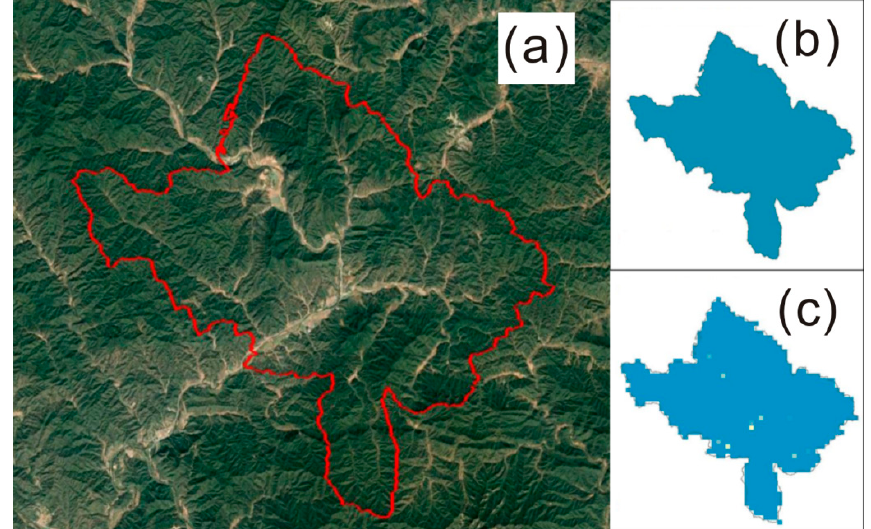
Figure 14. Comparison of the Google Earth image ( a ), census population data ( b ) and remotely-sensed population data ( c ) in Changshaoying Manchu township. The red line in ( a ) is the boundary of the township. Figures b and c use the same legend as Figure 9.